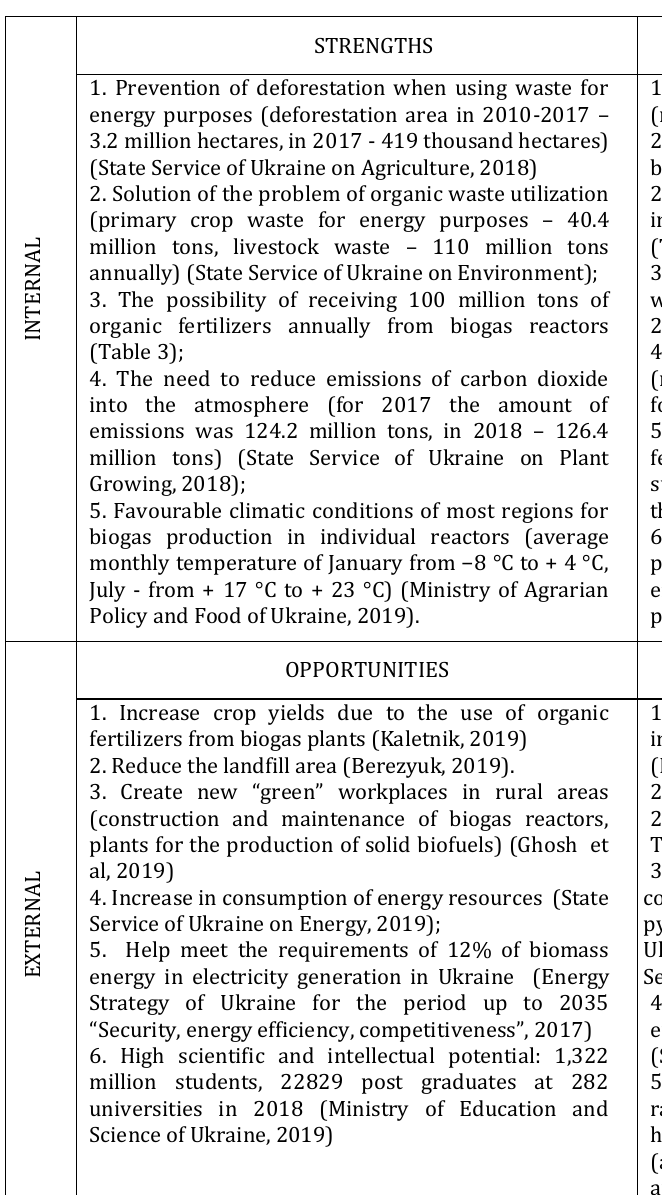
Table 7. SWOT- analysis of biofuels development from agricultural waste in Ukraine (Source: composed by the